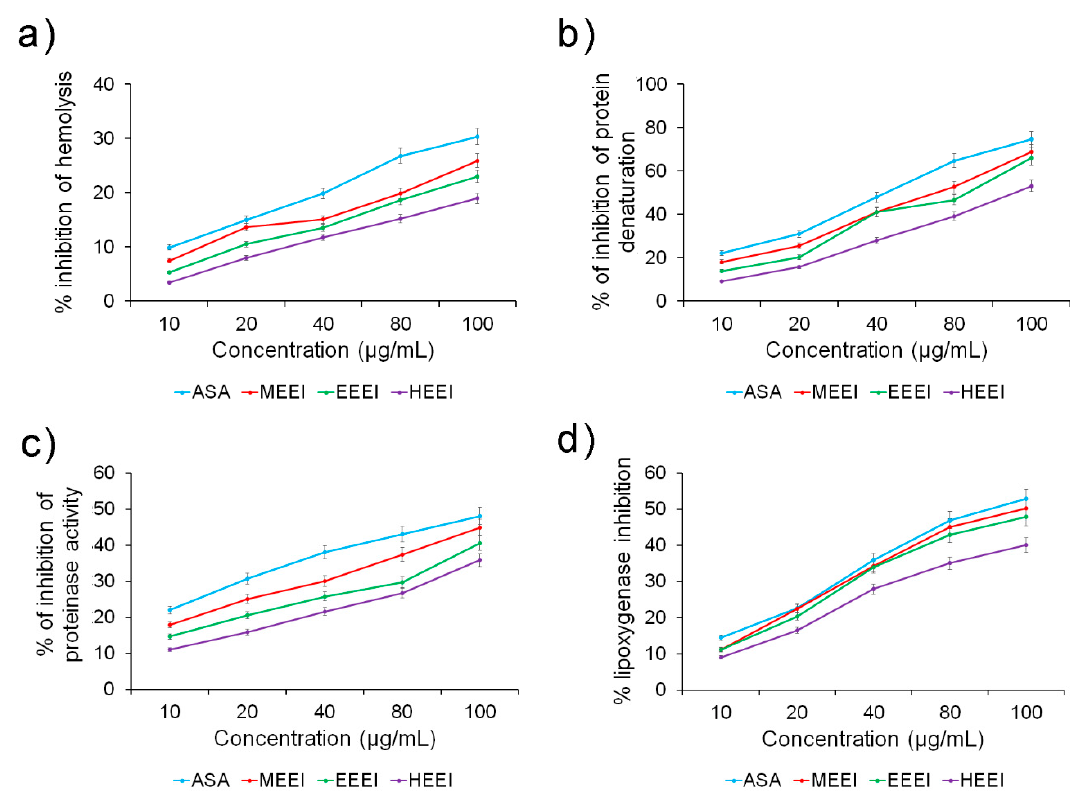
Figure 4. Anti-inflammatory capacity of different solvent extracts from E. intestinalis as determined by ( a ) hemolysis assay, ( b ) protein denaturation, ( c ) proteinase inhibitory activity, and ( d ) lipoxygenase inhibitory activity. Table 6. IC 50 values (in µg/mL) of the anti-inflammatory activity of the extracts of Enteromorpha intestinalis .